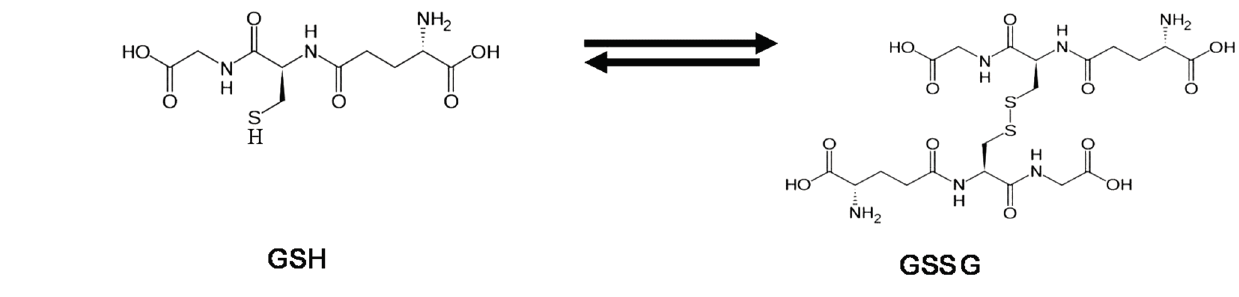
Scheme 1. Glutathione